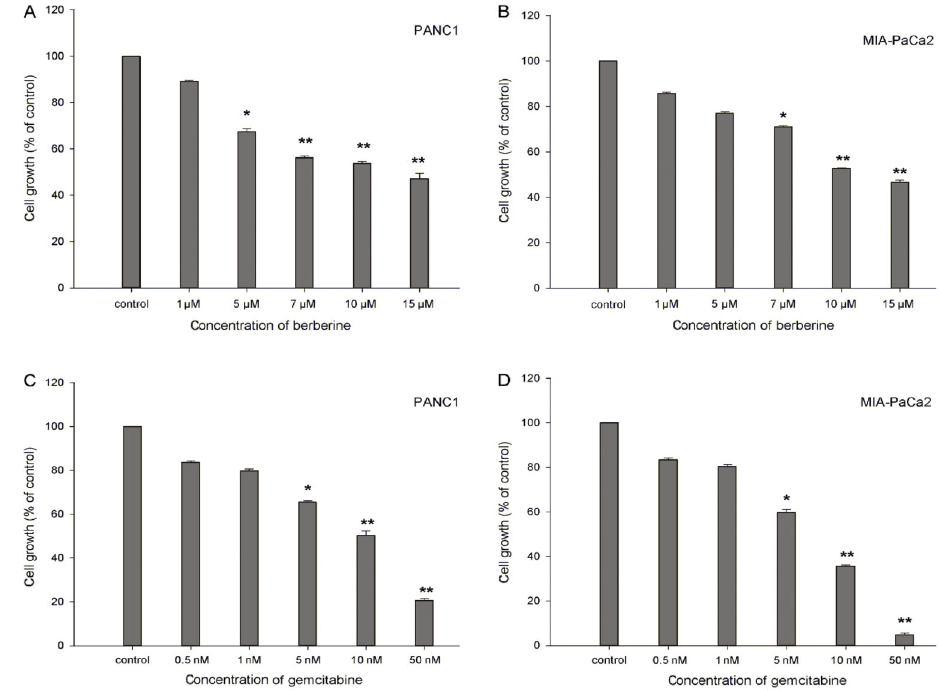
Figure 1. Cell growth rate after treatment of PANC-1 ( A , C ) or MIA-PaCa2 ( B , D ) pancreatic cancer cell lines with berberine or gemcitabine. The cells were treated with distilled water (control), berberine ( A , B ; 1, 5, 7, 10, or 15 m M) or gemcitabine ( C , D ; 0.5, 1, 5, 10, or 50 nM) for 72 h. Growth rate was calculated by trypan blue dye exclusion. Data showed relative cell survival rate as the percentage vs that of control cells after berberine or gemcitabine treatment. *P , 0.05, **P , 0.01 versus control (Student’s t